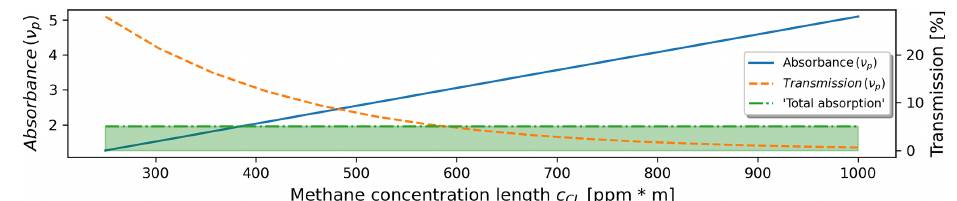
Figure 1. The absorbance of the peak wave number ν p = 3067 . 28cm − 1 is plotted in blue, the transmission is drawn in orange, and the green marked area shows the section of total absorption. Here, less than 5% of the laser light is transmitted through the gas.